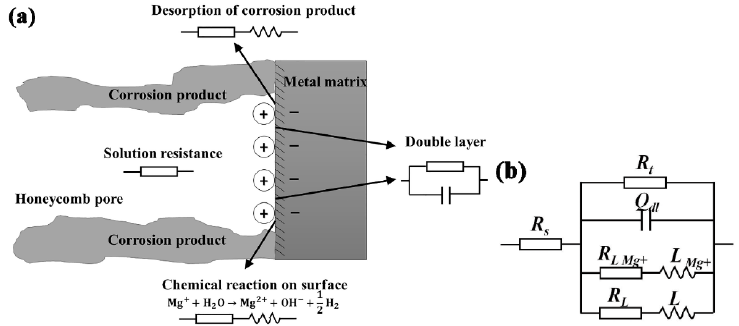
Figure 8. The dissolving surface model for describing the physical/chemical characteristics on the surface of alloys ( a ) and equivalent circuit ( b ).